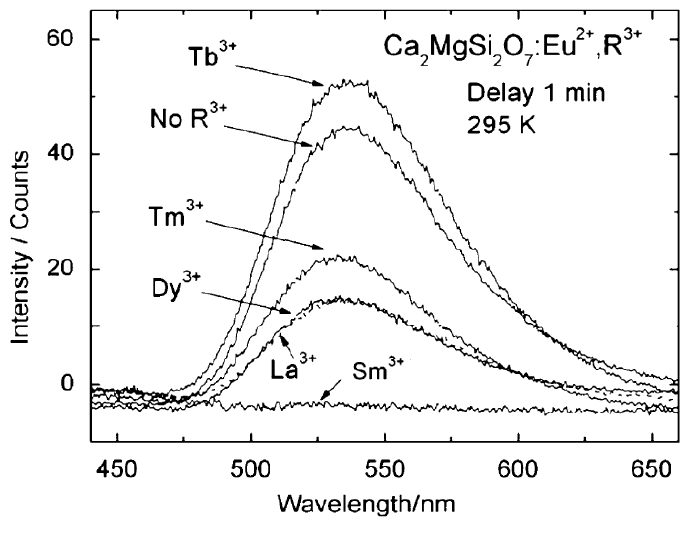
Figure 5. Persistent luminescence spectra of selected Ca 295 K. (Reprinted with permission from